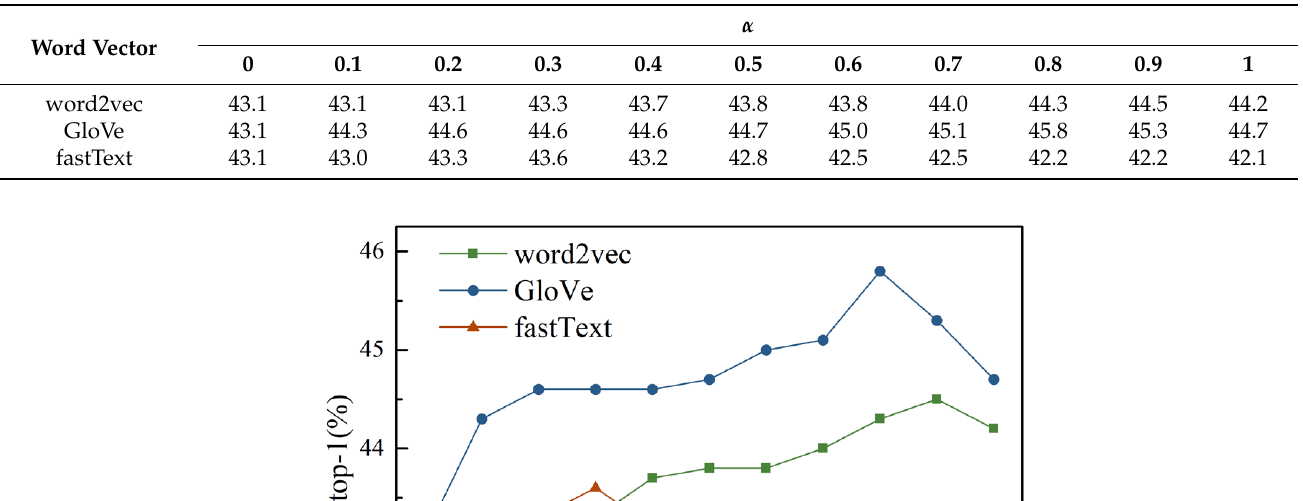
Table 4. Image classification top-1 accuracy of the test set.